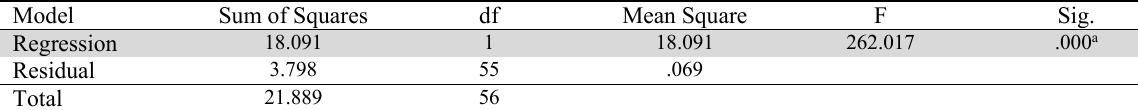
The results of the ANOVA test